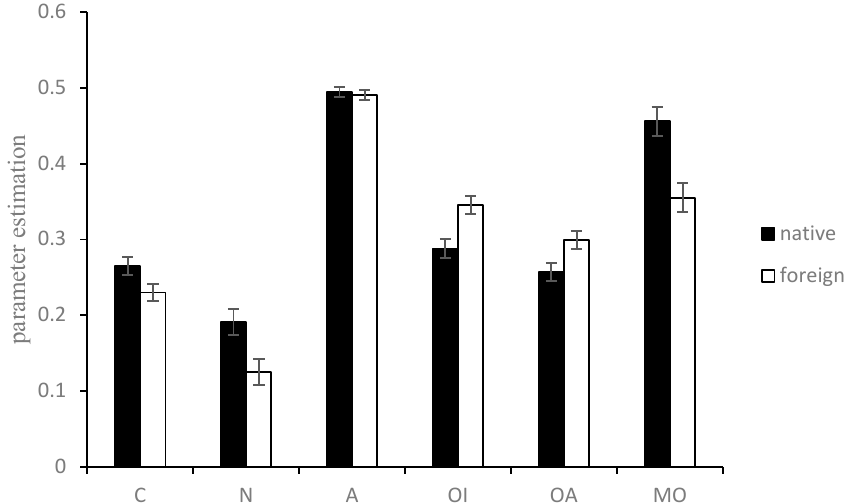
Figure 5. The parameter estimations using the CAN algorithm in the foreign/native language condition. Error bar represents the ± 1 standard error. Note. Covariates appearing in the model are evaluated at the following values: proficiency = 6.74, understanding = 8.43. Table 3. The MANOVA results in the combined sample (n =